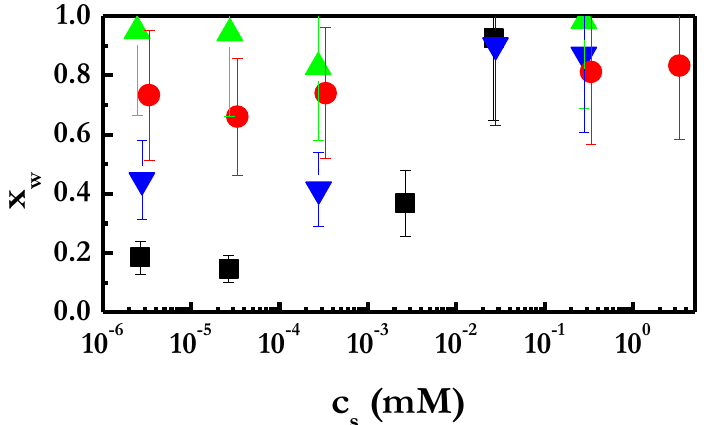
Figure 7. Dependence of water content, x w , on the surfactant concentration, c s , for the different DSPE-PEG+surfactant mixtures studied in this work: ( ■ ) SLES, (●) CB, ( ▲ ) SLES+CB (molar ratio 3:2) and ( ▼ ) SLMI. All the mixtures contain a fixed DSPE-PEG concentration of 5 g/L, and their ionic strength and pH were fixed a 40 mM (KCl) and 5.6, respectively. The dashed lines correspond to the values of acoustical and optical thicknesses for the adsorption of a DSPE-PEG layer from a solution with concentration 5 g / L and the same ionic strength and pH than the